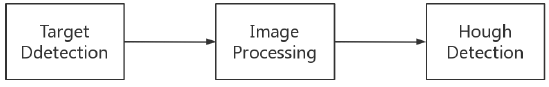
Figure 1. Traditional instrument identification